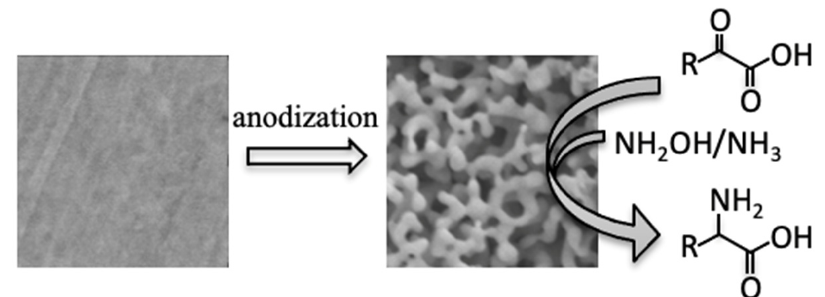
Figure 1. Schematic representation of electrochemical molecular conversion: nanostructurization for a commercially available planar-gold electrode surface and the electrochemical reductive amination of α -keto acid in the presence of a nitrogen source to produce L-amino acid.